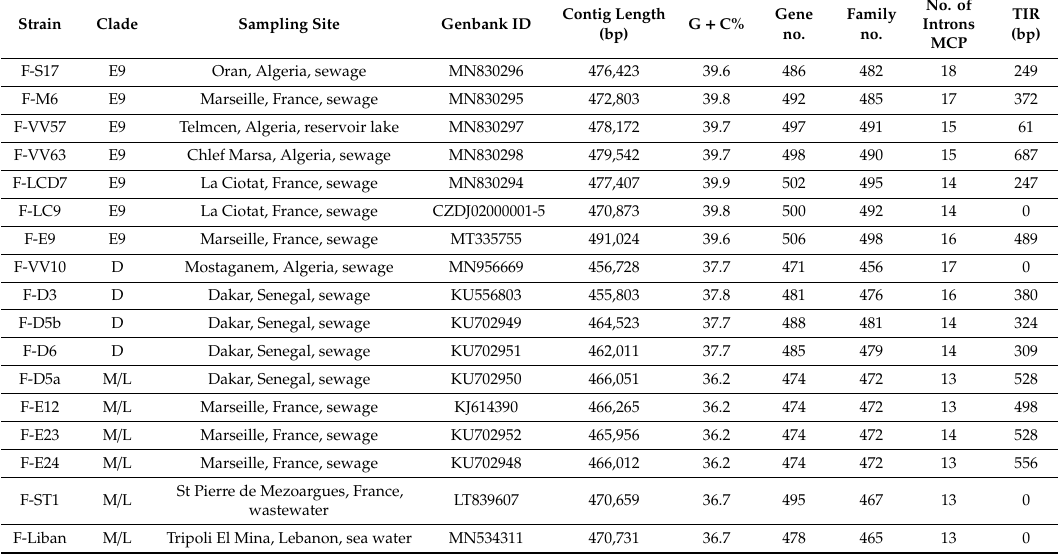
Table 1. Genomic features of Faustoviruses